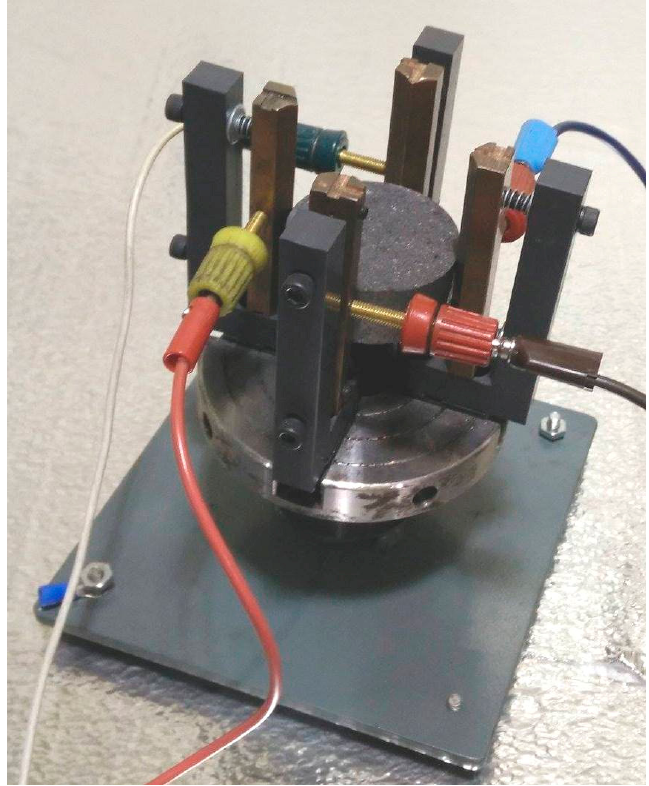
Figure 2. Picture of the Van der Pauw setting for laboratory measurement. The sample is placed at the center, between the four V-shaped copper probes.